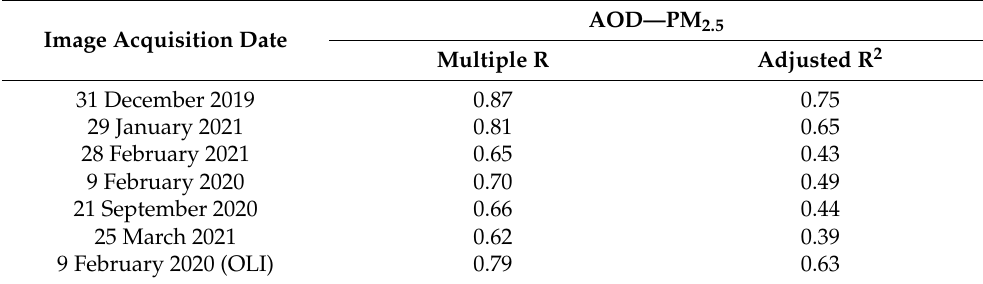
Table 5. Regression results for the AOD–PM 2.5 relationships (time-specific model